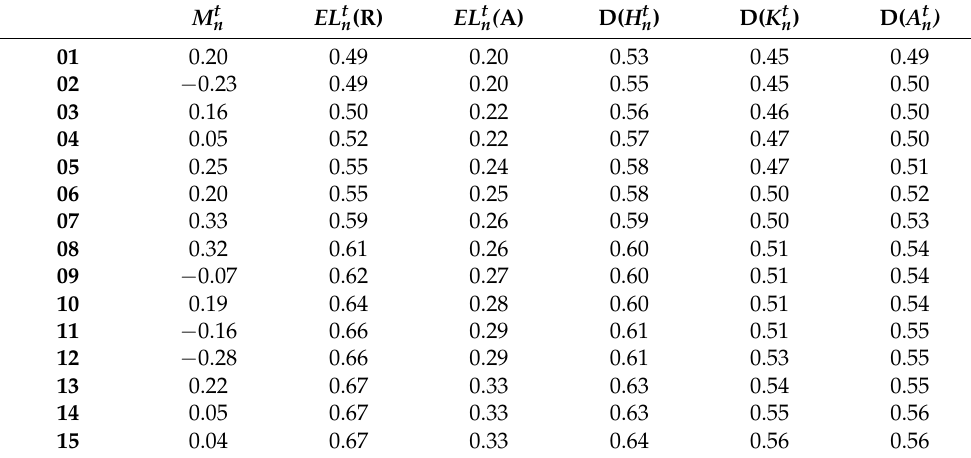
Table 5. Partial lower extremity comfort feature